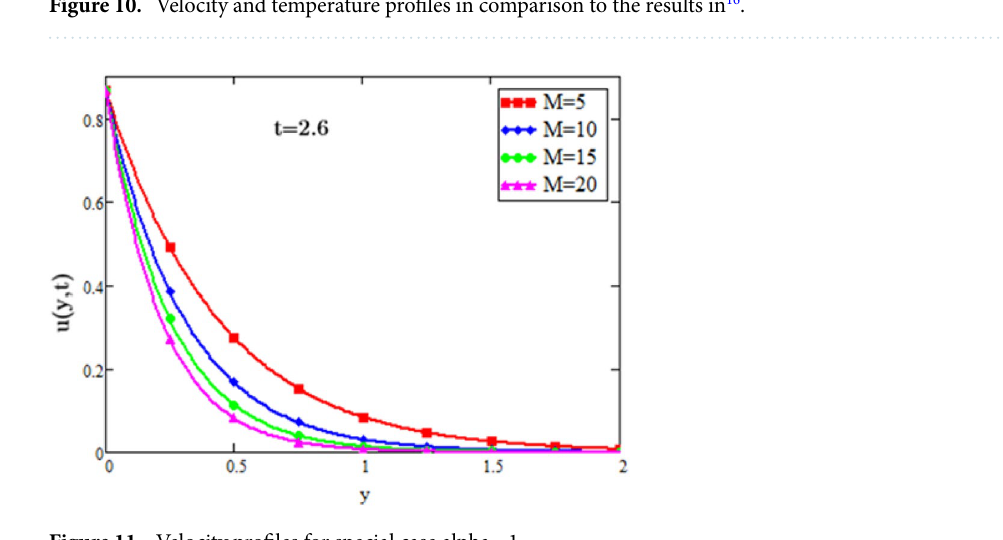
Figure 11. Velocity profiles for special case alpha =